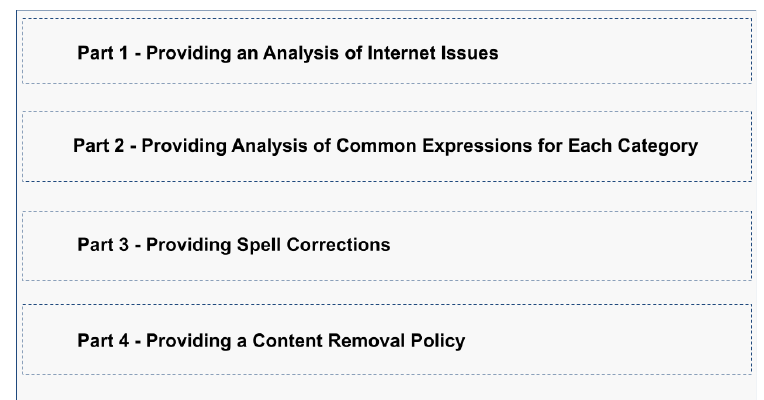
Figure 3. A hybrid dictionary model for offensive